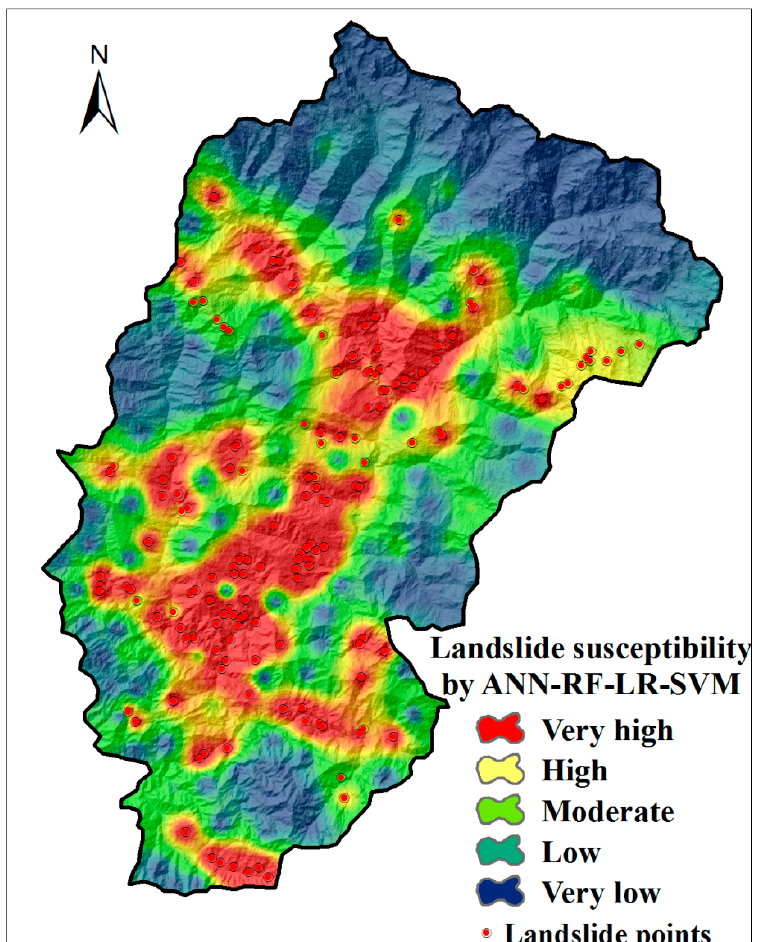
Figure 9. Landslide susceptibility mapping using ensemble of ANN-RF-SVM-LR.